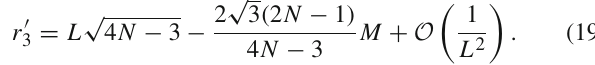
while the outer boundary of the NEC satisfied region, r (cid:10) monotonically increases with L